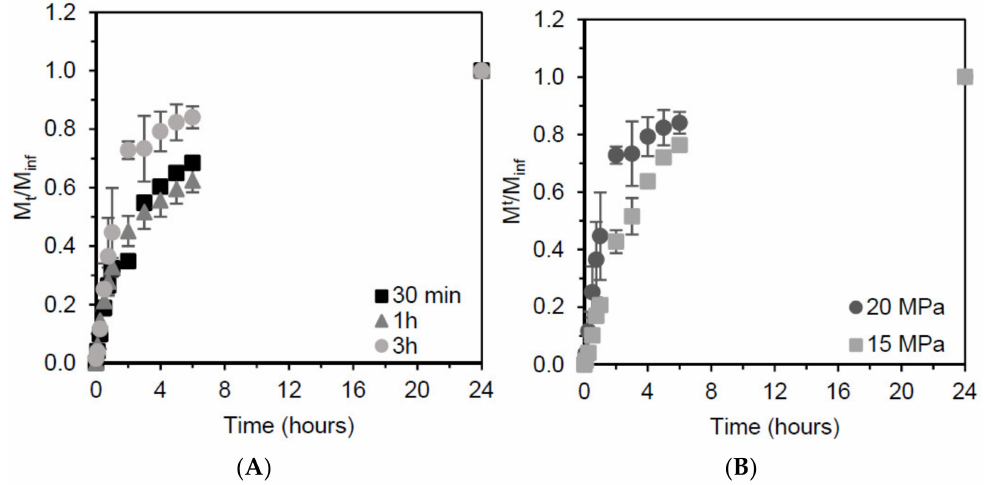
Figure 5. Release profile of ibuprofen from ( A ) mcl-PHA samples impregnated for different time periods (30 min, 1 h and 2 h) at 20 MPa and ( B ) mcl-PHA samples impregnated at 15 and 20 MPa for a period of 3